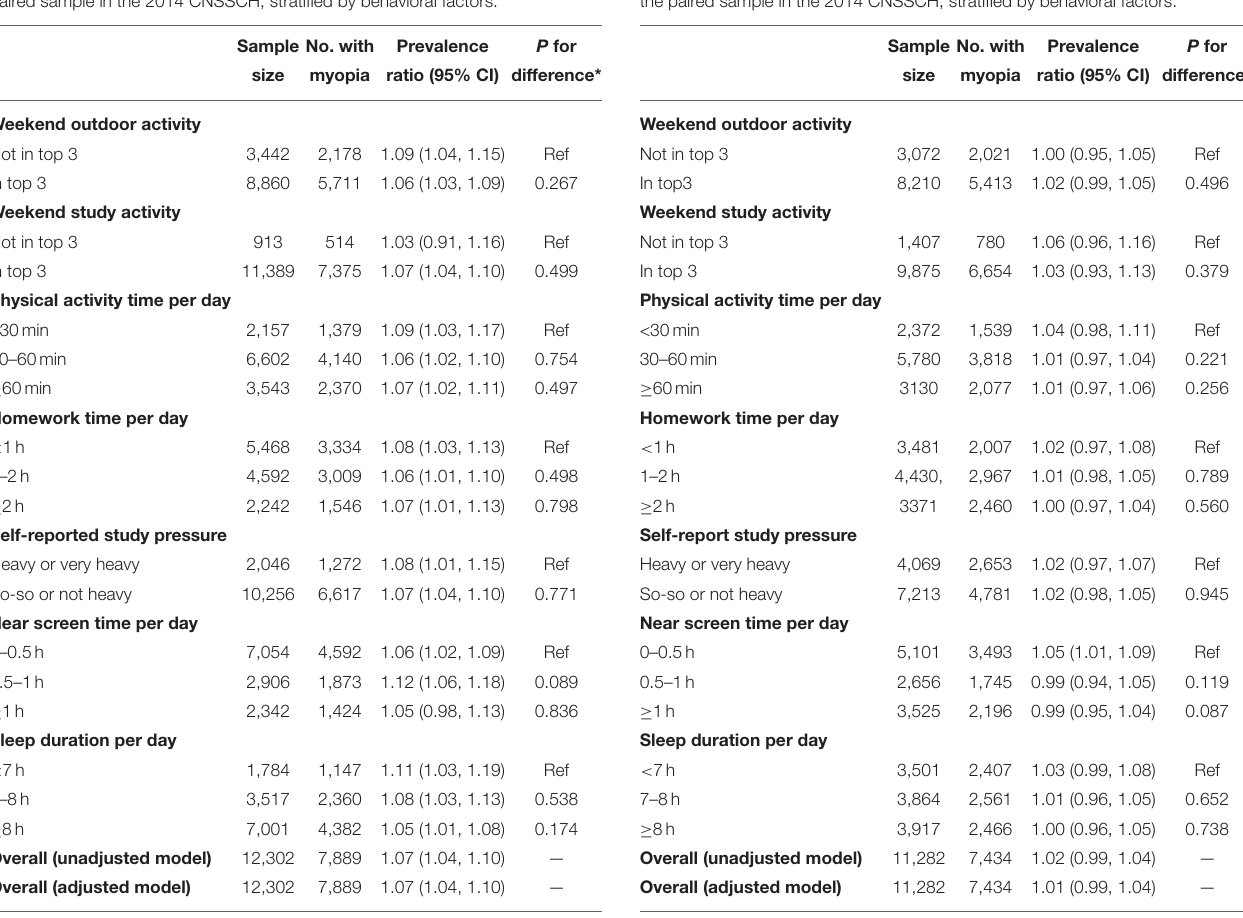
CNSSCH,ChineseNationalSurveyonStudents’ConstituteandHealth.Nearscreentime refers to time spent using a computer, cellphone, tablet, playing video games or reading e-books. In stratified analyses by behavioral factors, an unadjusted model was used to estimate the prevalence ratios and their 95% CI. The unadjusted model only controlled for the cluster effect of school, while the adjusted model further controlled all behavioral factors in this table. * estimated by adding an interaction term to the model. “in top 3” and “not in top 3” refers to whether the outdoor (or study) activity is a top 3 choice that the participant usually does on